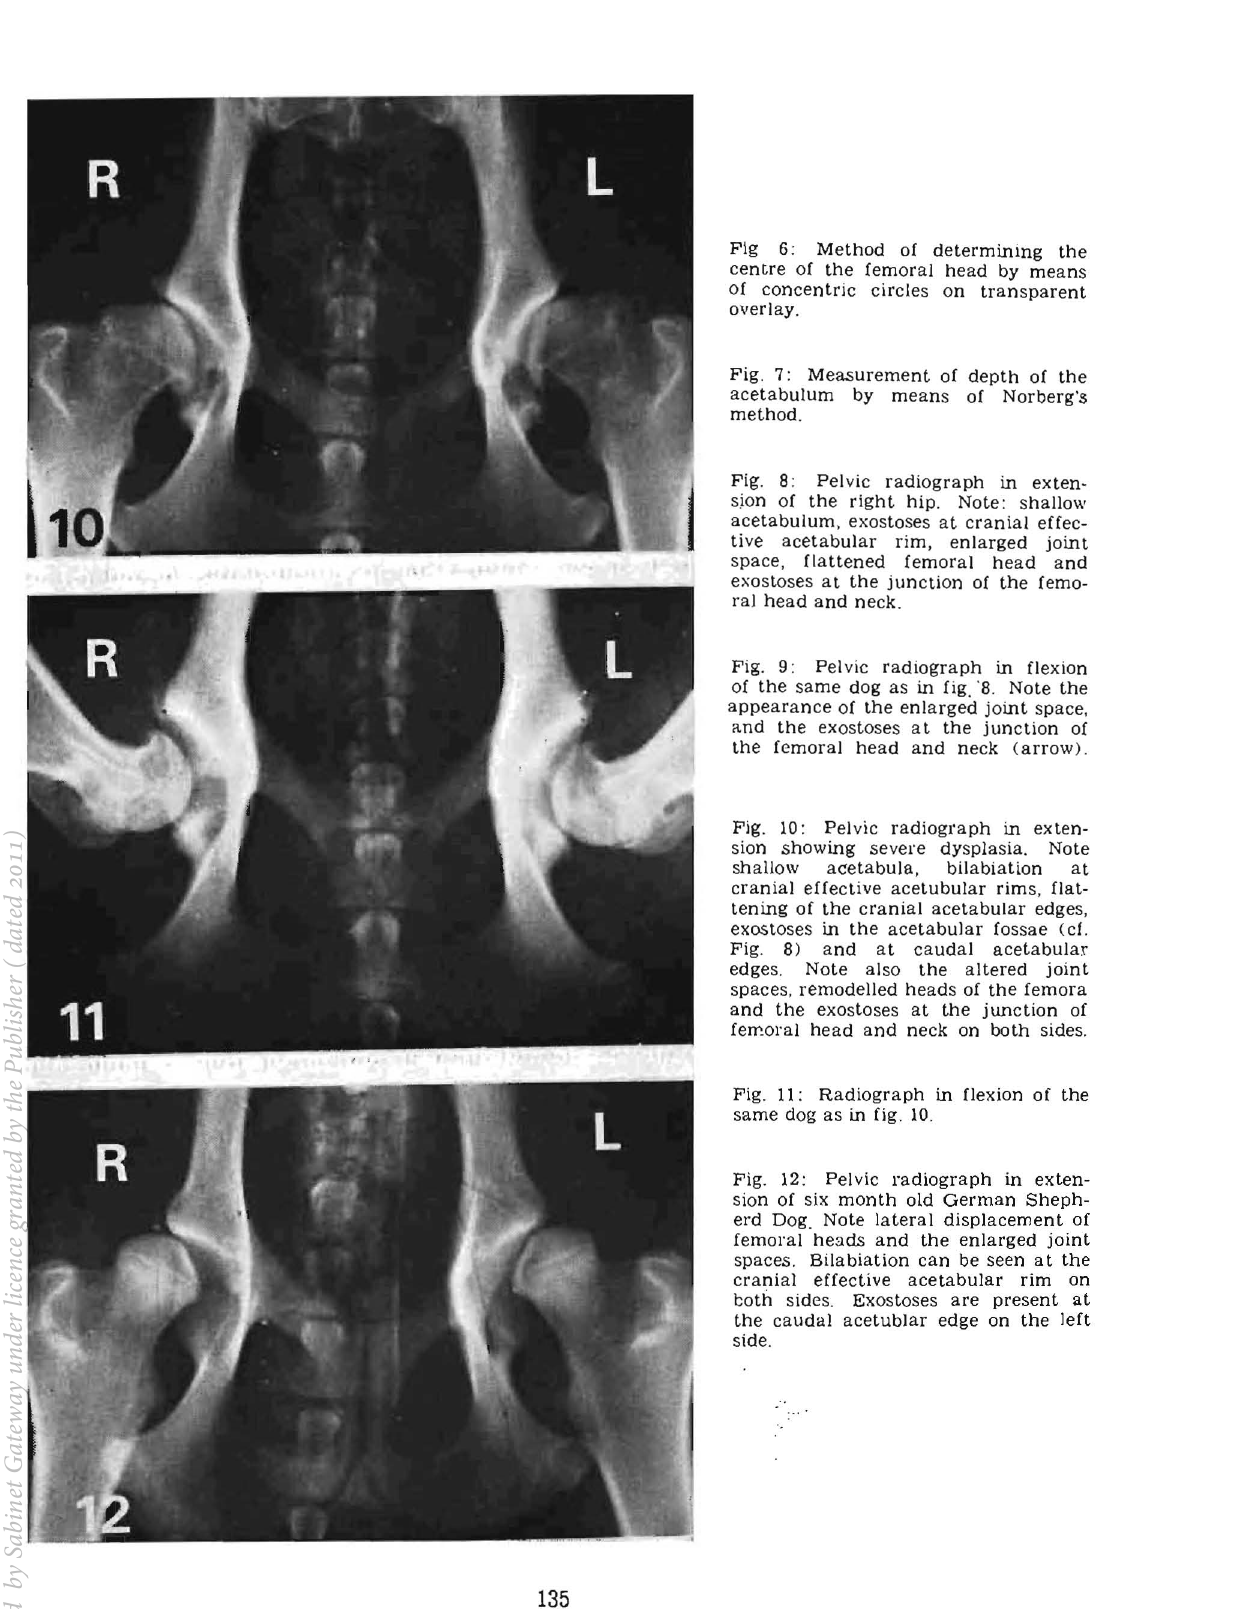
Fig. 11: Radiograph in flexion of the same dOg as in fig. 10. Fig. 12: Pelvic radiograph in exten Sion of six month old German Sheph erd Dog. Note lateral displacement of femoral heads and the enlarged joint spaces. Bilabiation can be seen at the cranial effective acetabular rim on both sides. Exostoses are present at the caudal acetublar edge on the left